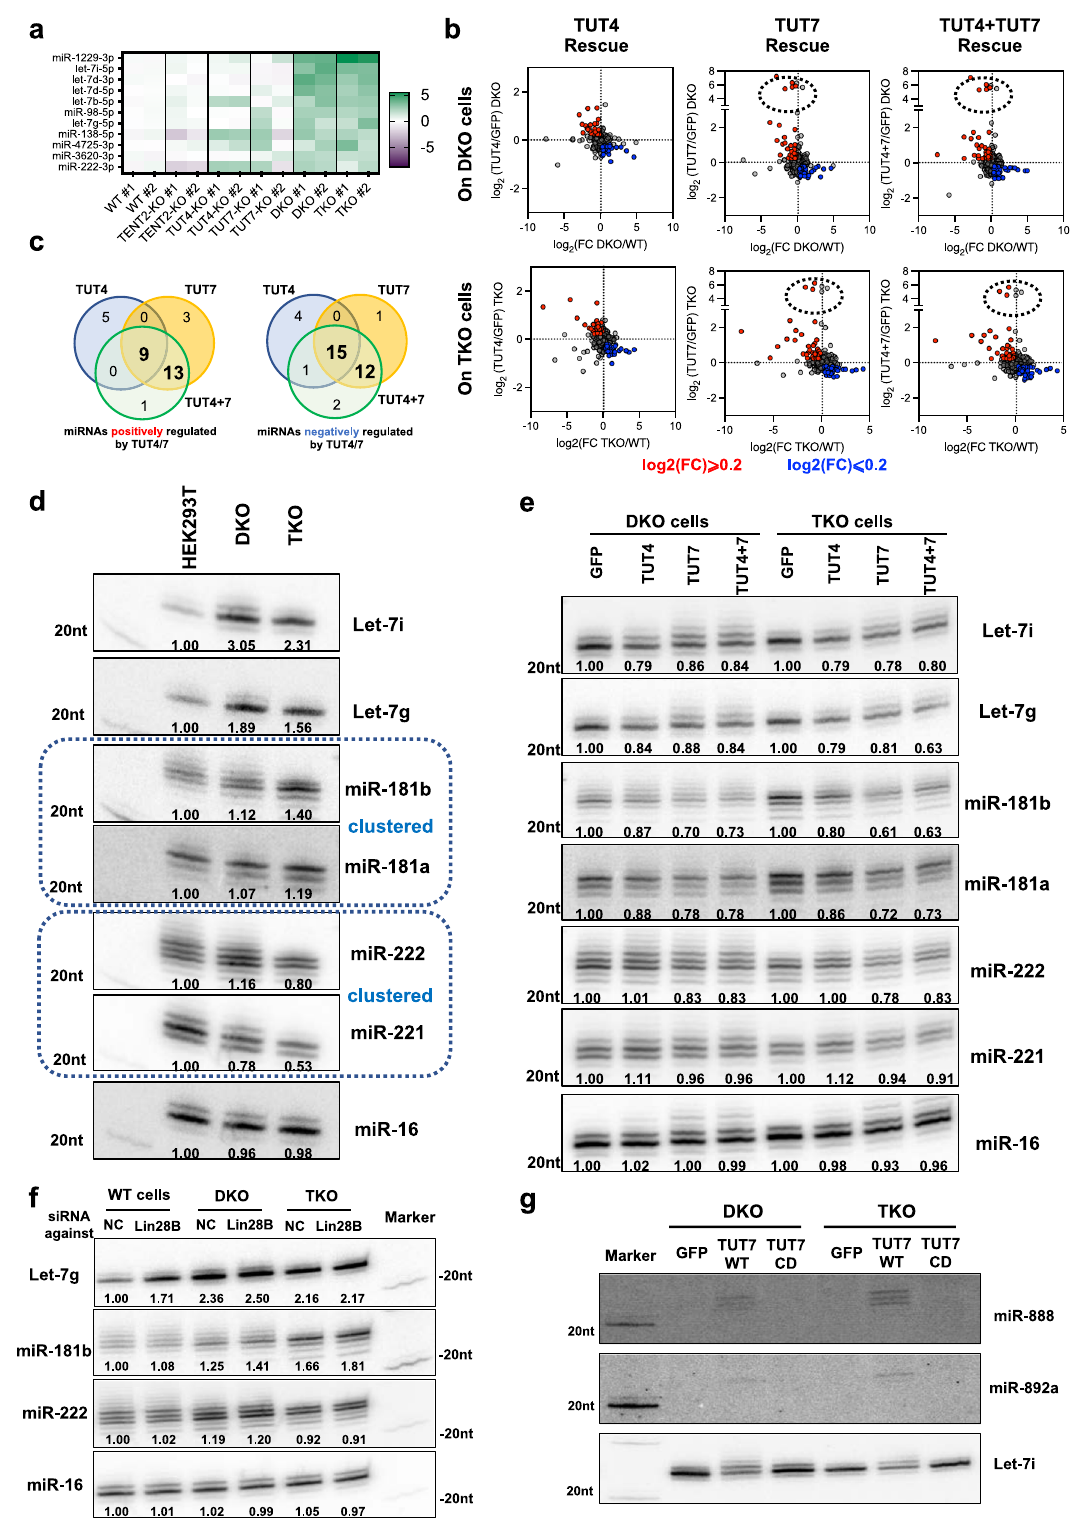
Fig. 6 | TUT4/7 regulate the abundance of a set of miRNAs via distinct mechanisms. a Heatmap illustrating the miRNAs with the highest expression increaseuponTENT2,TUT4,andTUT7knockouts. b Analysiscomparingtheeffects on miRNA abundance upon knockout and rescue with TUT4, TUT7, or TUT4/7 in differentgeneticbackgrounds.Coloreddotsindicatelog2(FC)l ≥ 0.2(upregulation, red)andlog2(FC) ≤ 0.2(downregulation,blue).Dashedcircleindicatesmembersof the miR-888 cluster. c Venn diagramillustrating miRNAspositively (left panel)and negatively (right panel) regulated by TUT4/7. This diagram was based on the